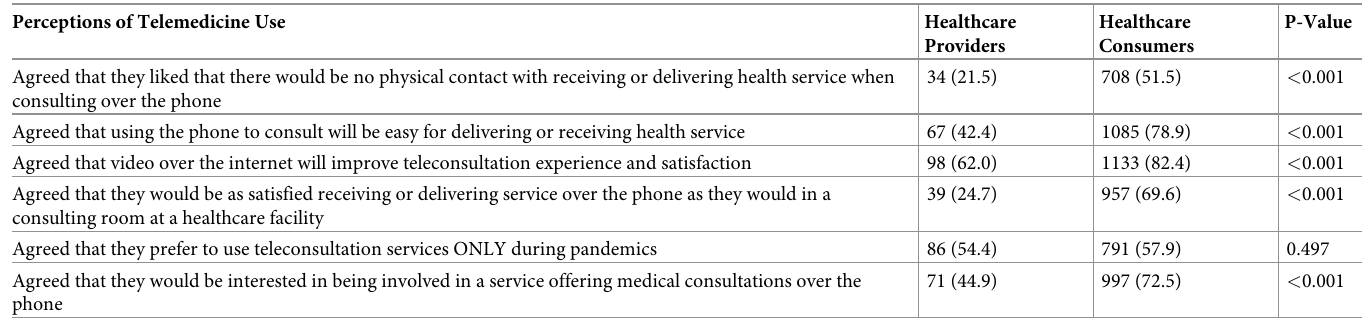
Table 3. Comparison of healthcare providers and health care consumers overall perceptions on telemedicine use. Perceptions of Telemedicine